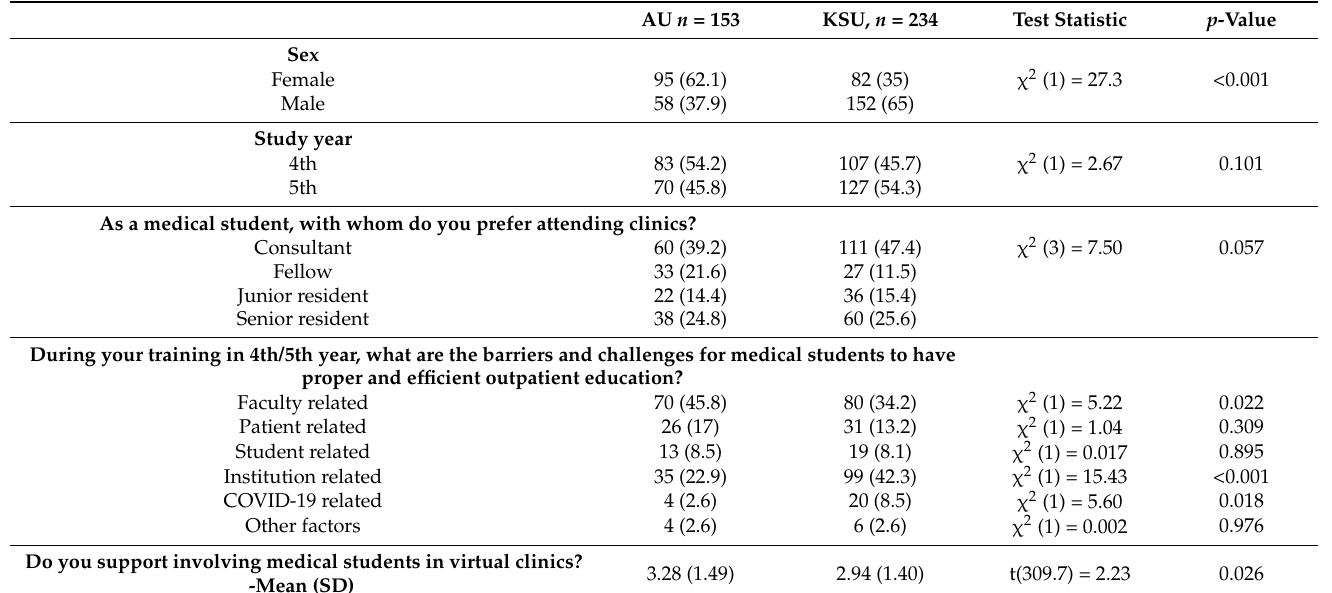
Table 4. Bivariate comparison of the students from the two universities on their perceived learning preferences and